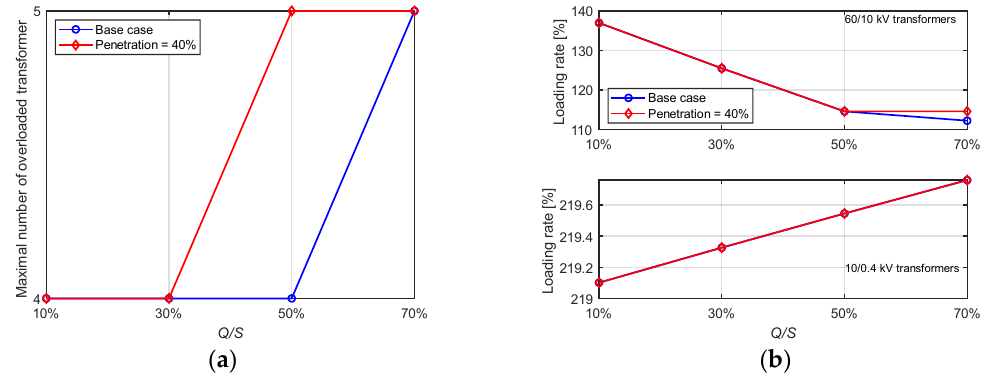
Figure 12. The worst overloading situations of transformers at different Q setpoints (with constant Q ): ( a ) Yearly maximum number of overloaded transformers; ( b ) Yearly maximum loading rate.